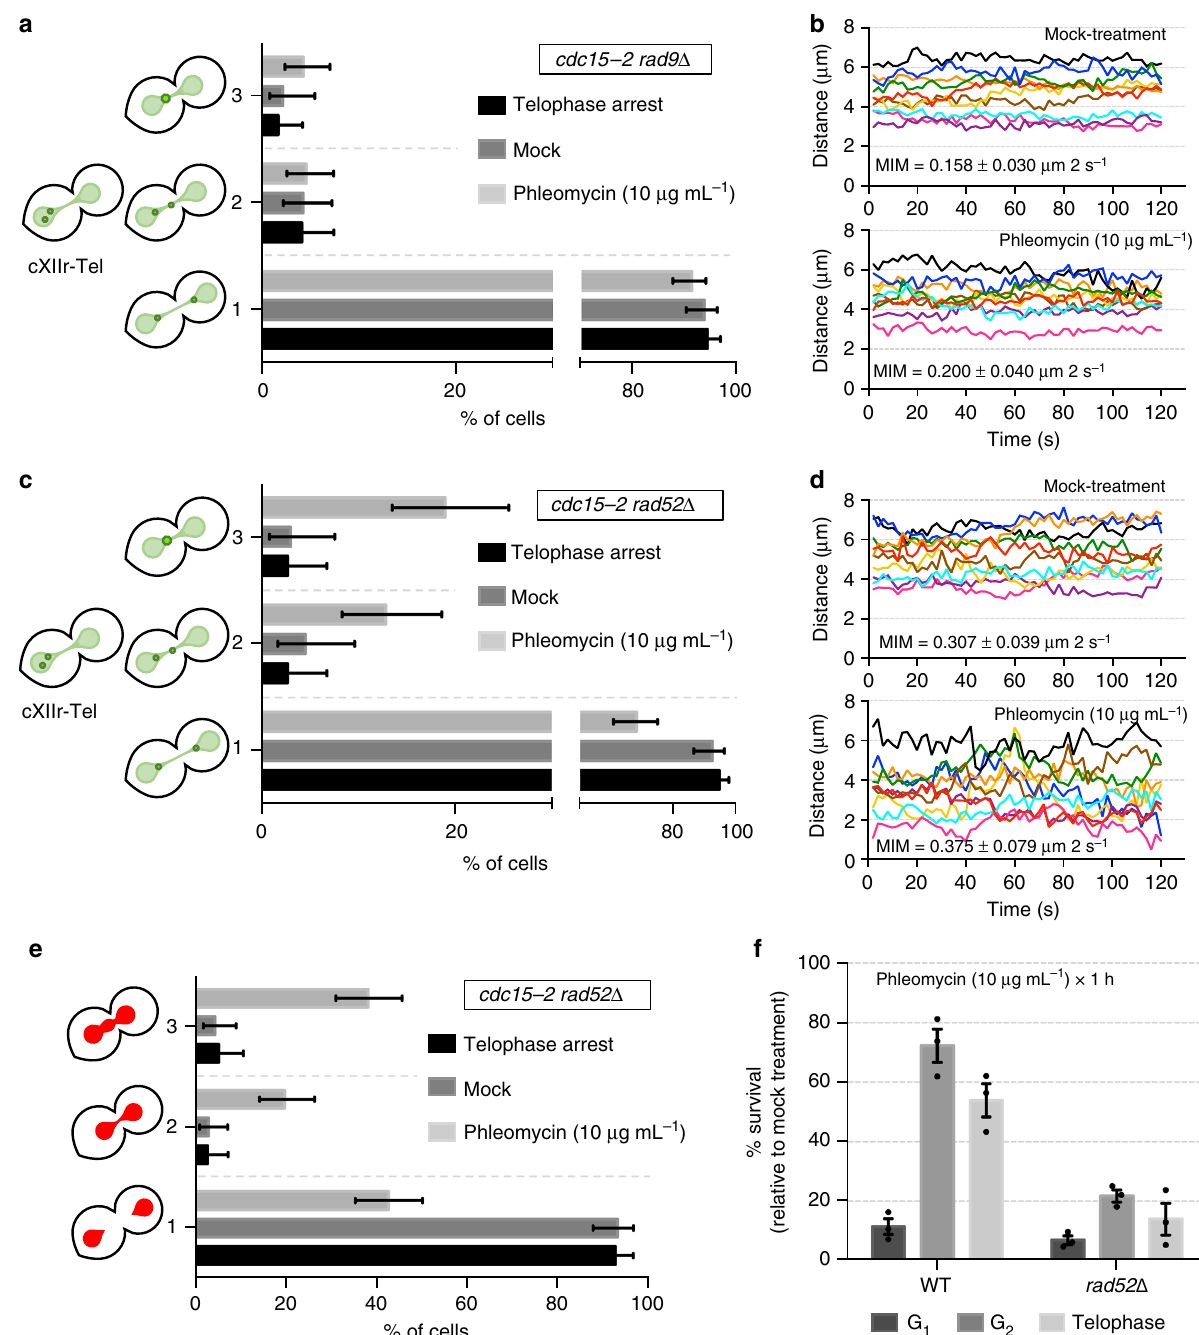
Fig. 4 Sister loci acceleration and coalescence in telophase depends on Rad9 but is independent of Rad52. a Sister telomeres need the DNA damage checkpoint (Rad9 branch) to move to the same cell body and coalesce after DSBs in telophase. FM916 ( rad9 Δ ) was treated like in Fig. 2a. Relative position of cXIIr sister telomeres was categorised as depicted on the left (one representative experiment ± CI95); categories 1, 2 and 3 as de fi ned in Fig. 3a. b The increase in inter sister telomere movement also depends on Rad9. Kinetograms of 2-min movies from 10 randomly selected cells in the previous experiment. The MIM is also displayed within the charts (mean ± s.d., n = 10 cells). Note that the acceleration in interloci movement after phleomycin addition is only one-third of that observed in DDC-pro fi cient cells (compare with Fig. 3c). c Sister telomeres coalescence is independent of a functional HR. FM889 ( rad52 Δ ) was treated like in Fig. 2a. Relative position of cXIIr sister telomeres was categorised as depicted on the left (one representative experiment ± CI95); categories 1, 2 and 3 as de fi ned in Fig. 3a. d Rad52 restrains inter sister telomere movement in telophase. Kinetograms of 2-min movies from 10 randomly selected cells in the previous experiment. The MIM is also displayed within the charts (mean ± s.d., n = 10 cells). Note how MIM is already doubled in the mock treatment when compared with the wild type (Fig. 3c). e Formation of de novo chromatin bridges is independent of Rad52. Samples from the previous experiments were taken and the nuclear mass stained with Hoechst. Nuclear morphology was categorised as followed: 1, binuclear; 2, thin bridge; 3, gross/bulgy bridge (±CI95). f HR repairs DSBs in telophase. Clonogenic survival of strains FM588 (WT) and FM889 ( rad52 Δ ) arrested in G 1 , G 2 or telophase before treated with phleomycin (mean ± s.e.m., n = 3 independent experiments). Survival is normalised to a parallel mock- treated culture (reference for 100% survival). Source data are provided as a Source Data fi